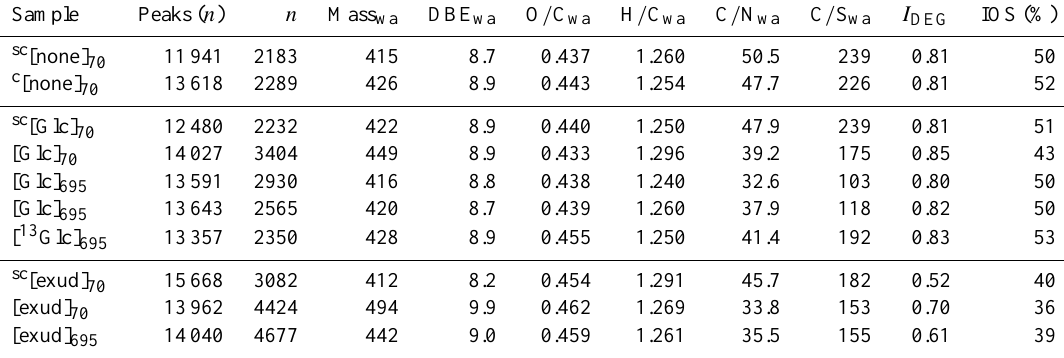
Table 4. Mean data of the molecular characterization via FT-ICR MS: number of identified peaks in the spectrum (signal-to-noise ratio ≥ 4), number of formulas assigned ( n ), peak magnitude weighted averages (wa) of the molecular mass (Mass wa ), double bond equivalent (DBE wa ) , oxygen-to-carbon ratio (O / C wa ), hydrogen-to-carbon ratio (H / C wa ) , carbon-to-nitrogen ratio (C / N wa ) and carbon-to-sulfur ratio (C / S wa ) . The degradation index ( I deg ) indicates the relative state of degradation of marine SPE-DOM using electrospray ionization in negative mode (Flerus et al., 2012). IOS (%; island of stability, Lechtenfeld et al., 2014) is the total relative peak magnitude of the most stable molecular formulas compared to the total peak magnitude of all CHO containing molecular formulas.